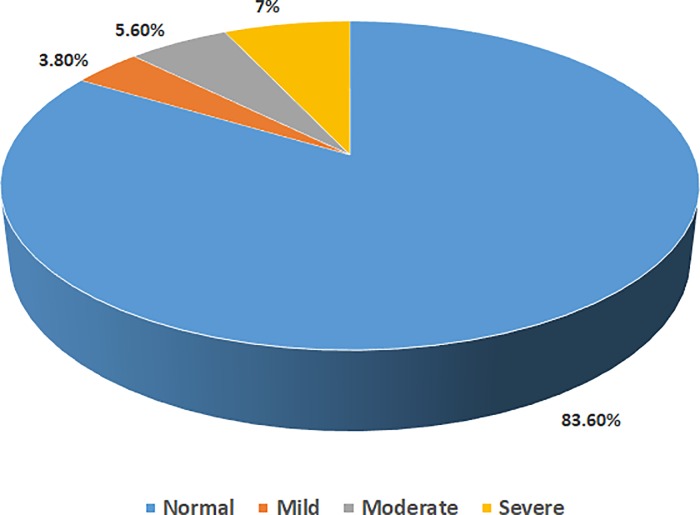
Distribution of left ventricular ejection fraction according to the severity.